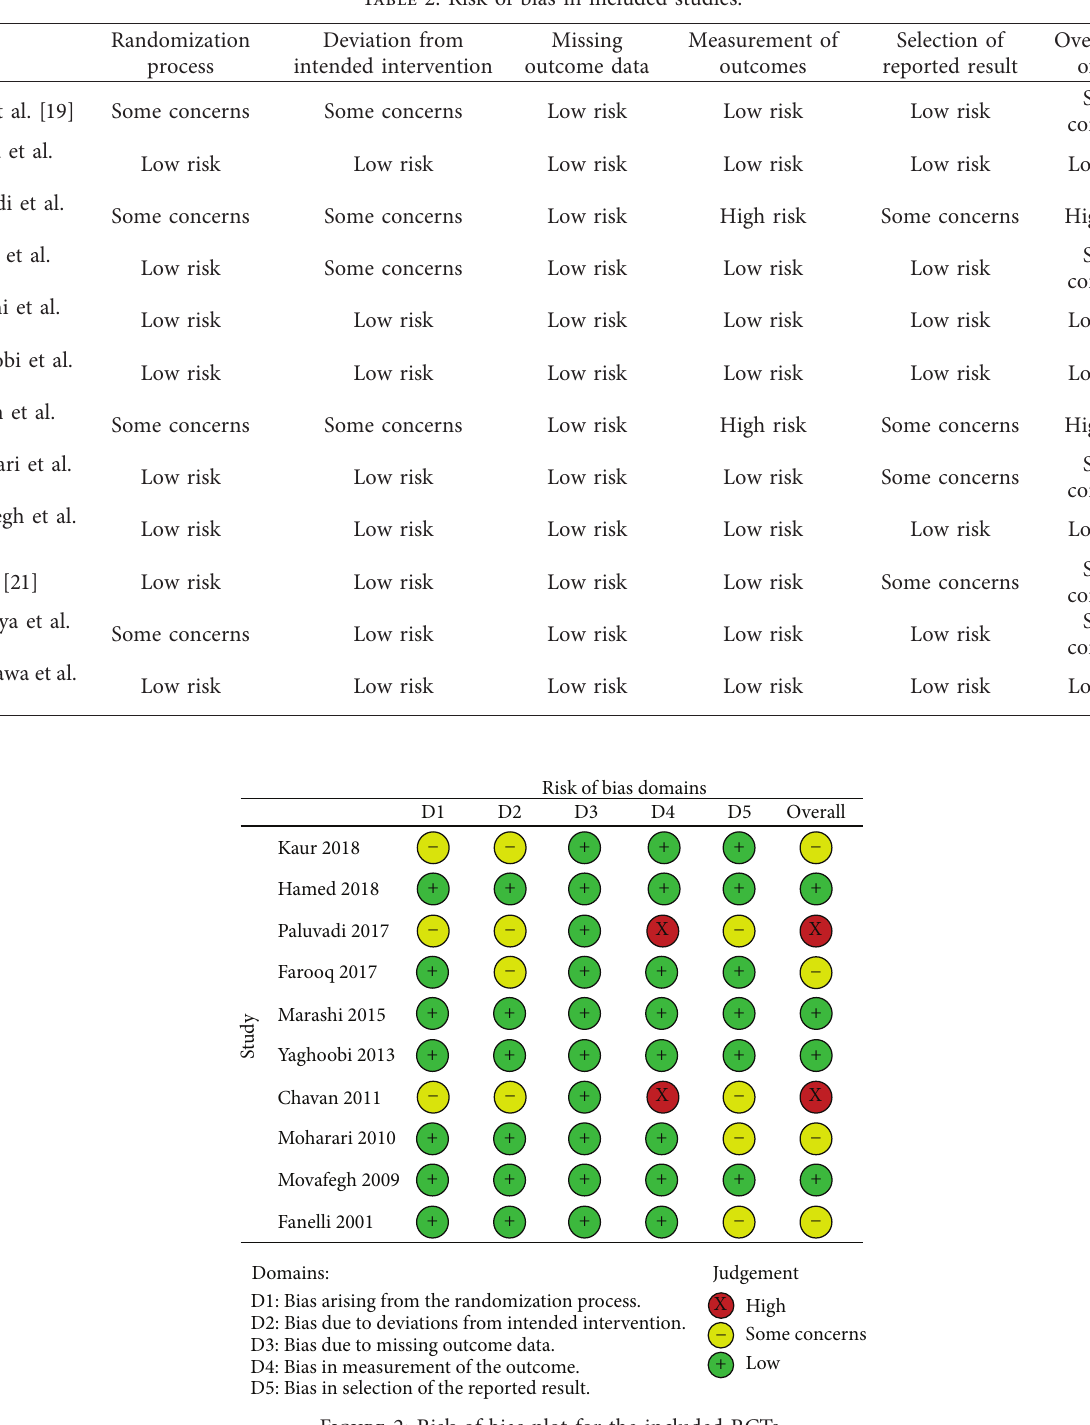
Table 2: Risk of bias in included studies.